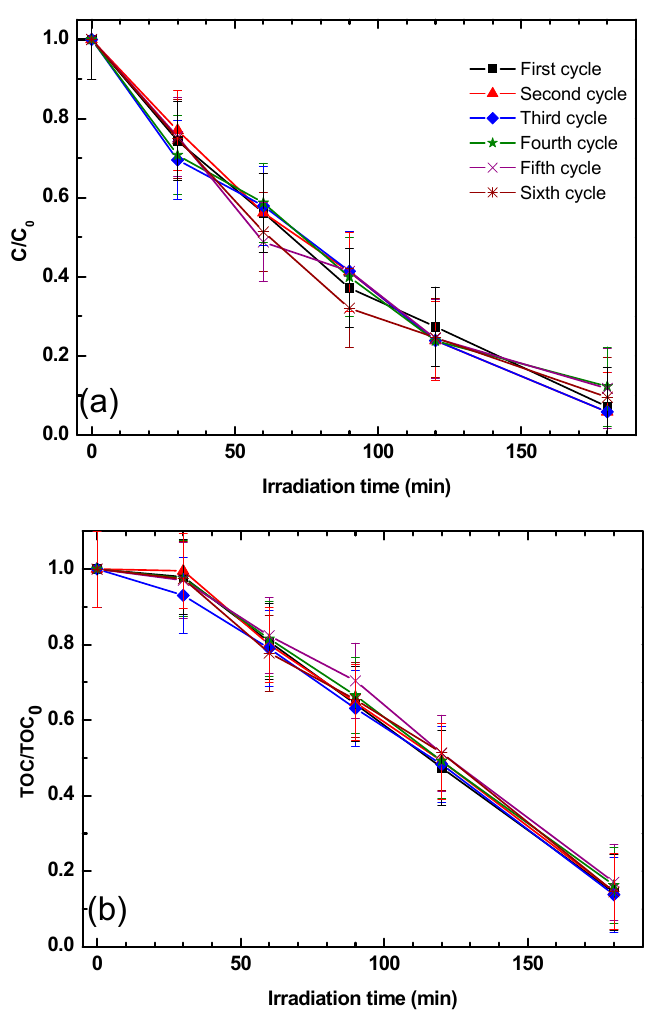
Figure 5. ( a ) phenol and ( b ) the total organic carbon (TOC) concentration aqueous solutions treated with the same 2ZnO / s-PS δ -form aerogel sample. No regeneration step of the aerogel was performed at the end of each cycle.